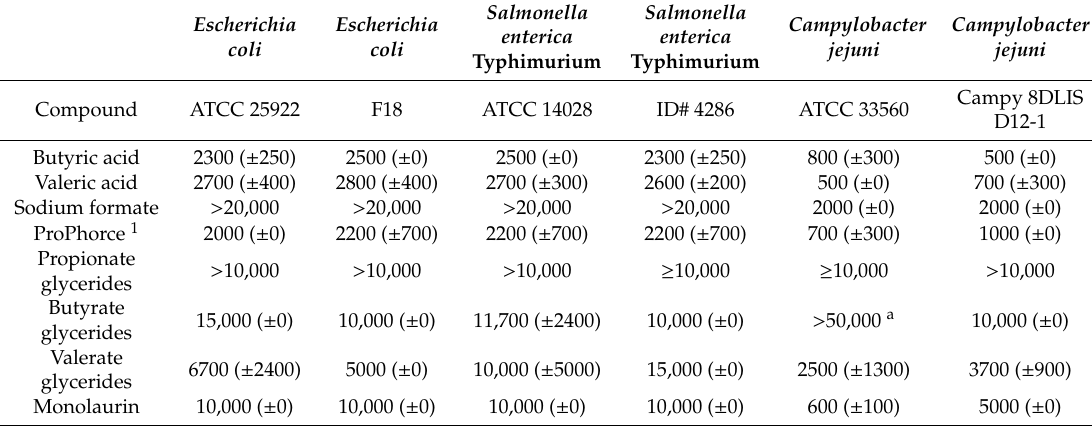
Table 2. Minimum inhibitory concentrations (mg/L) (±SD) of organic acids and their derivatives on tested Gram-negative (G−) bacteria strains.